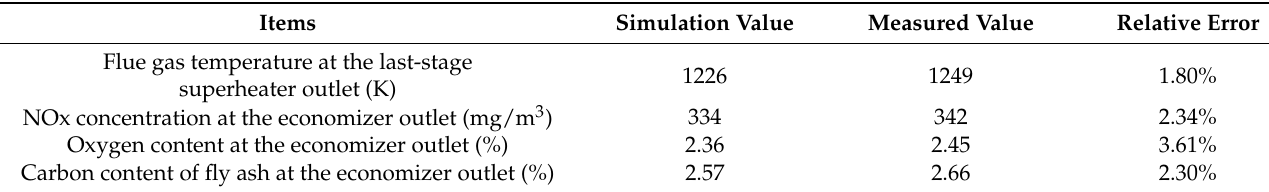
Table 2. Comparison between the numerical simulation results and the field measured data under the base operation